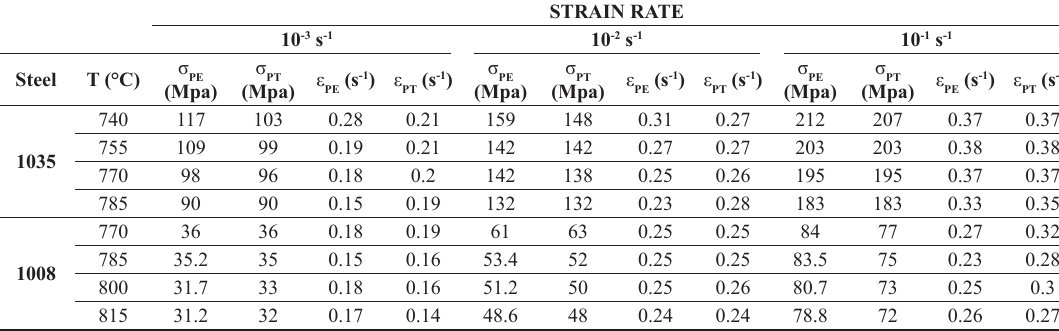
Table 7. Peak and steady state stress to different strain